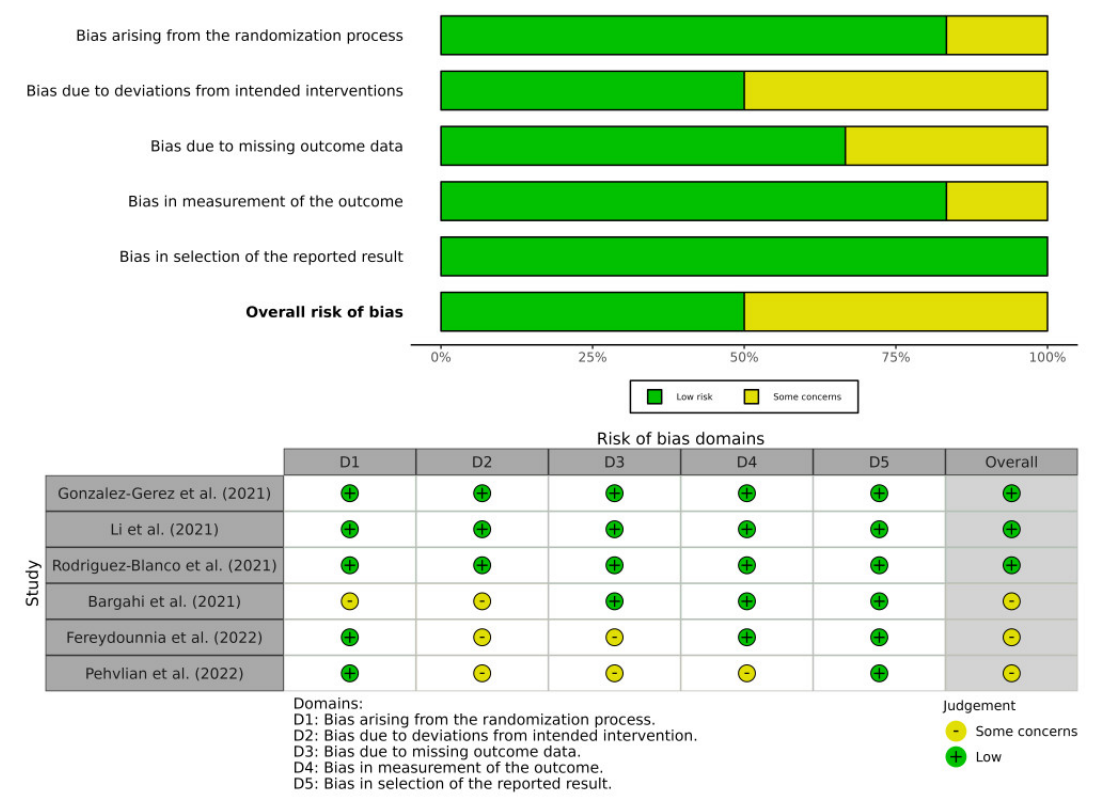
Figure 2. Risk of bias of RCTs assessed with RoB 2.0. Table 2. Methodological quality evaluation of the clinical trials using the Cochrane Risk of Bias Tool for assessing the risk of bias in randomized trials.